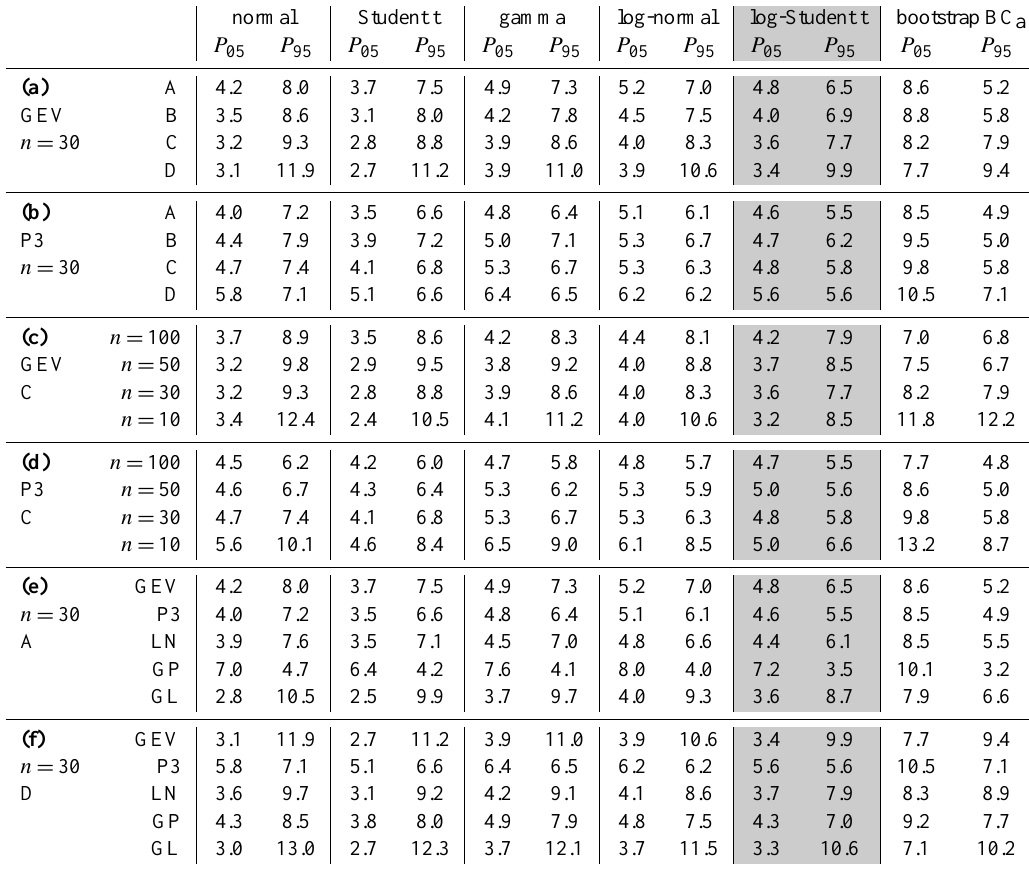
Table 2. Coverage of the 90% confidence intervals for τ using the following candidate distributions: corrected parametric model with normal, Student t, gamma, log-normal and log-Student t distribution, bootstrap BCa model with 2000 replicates. P 05 and P 95 are the percentage of trials (that are 10000) that the indicated interval missed the true value τ on the left or right side of the confidence interval. The same cases (a – f) of Table 1 are considered